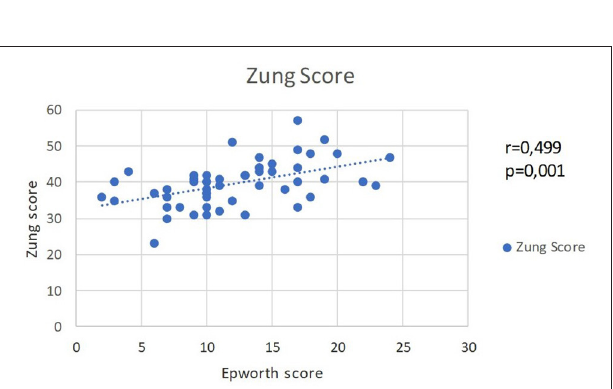
FIGURE 3 | A moderate straight correlation is evident between EES scores and Zung scores.